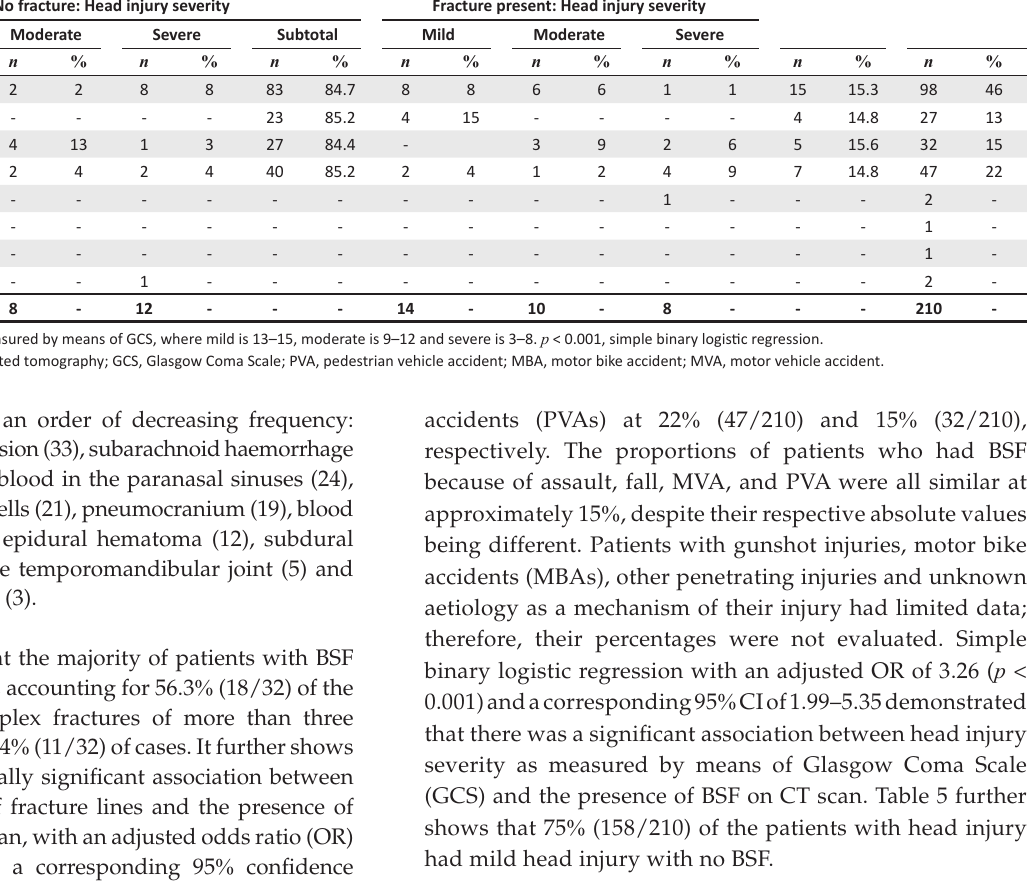
FIG URE 3: (a) Axial, (b) coronal and (c) sagittal computed tomography bone window with a right occipital condylar fracture (arrows). TABLE 5: Summary of severity of head injury and basal skull fracture in relation to mechanism of injury ( n = 210). Mechanism of